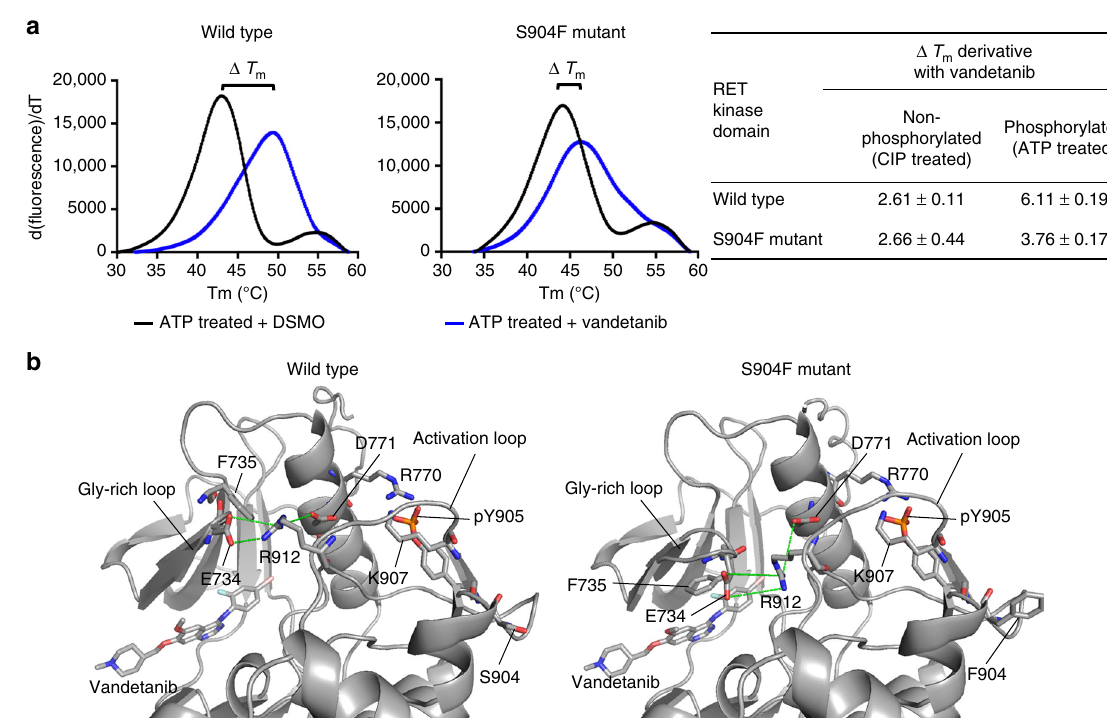
Fig. 4 Decreased thermal stability of the RET kinase-vandetanib complex induced by the S904F mutation. a A thermal shift assay was performed to determine the drug-induced changes in the melting temperature ( Δ T m ) of puri fi ed RET KD, which re fl ect the stability of the complex 13 . Recombinant wild type or S904F mutant RET KD was generated using previously published methods 13 . Each protein was dephosphorylated using CIP-phosphatase and then either used directly (unphosphorylated) or phosphorylated by addition of Mg-ATP, followed by incubation with DMSO or 1 µ M vandetanib. Wild type and S904F mutant RET KDs without drug showed T m values of 43.00 ± 0.06 °C and 44.16 ± 0.04 °C, respectively (Supplementary Table 1). Addition